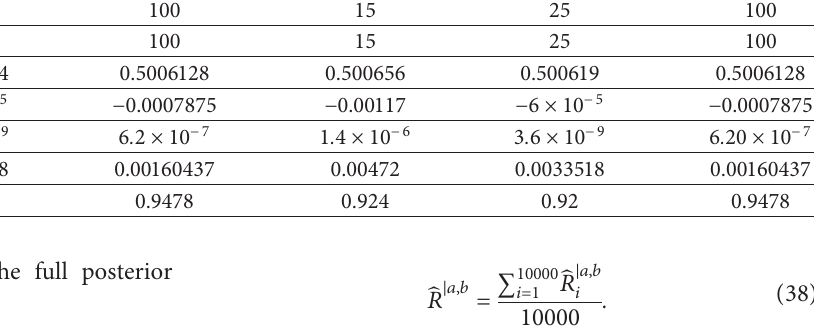
� 3, α � 3, λ � 1 . 5, 1 2